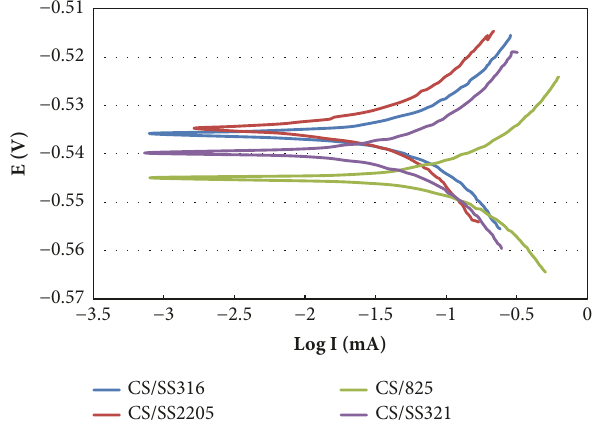
Figure 6: Evans diagrams for all galvanic couples in stagnant deaerated 3.5% ABS at 60 ∘